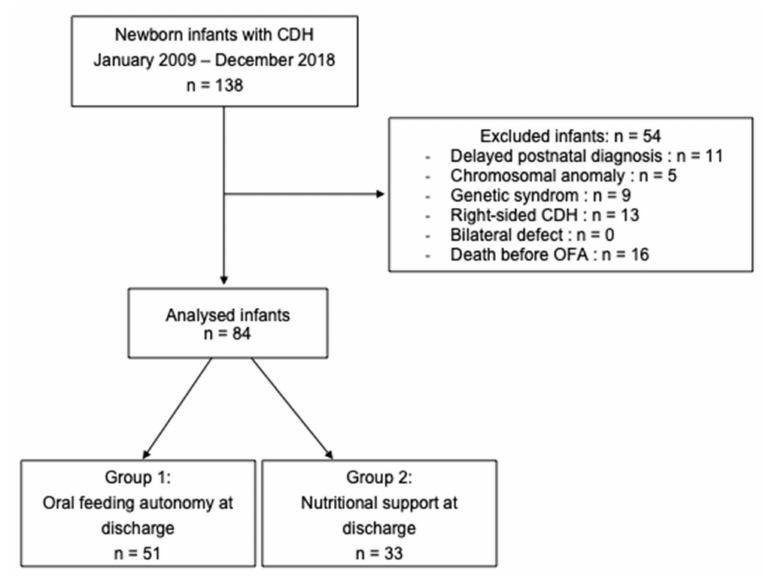
Figure 1. Flowchart. Congenital Diaphragmatic Hernia (CDH); Oral Feeding Autonomy